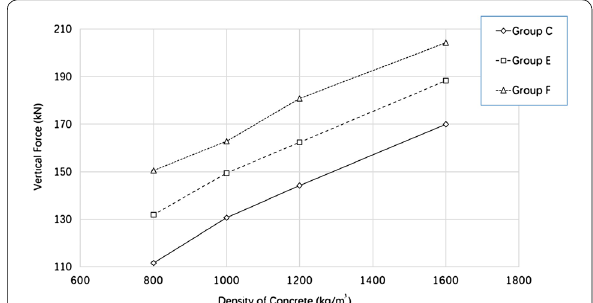
Fig. 5 Peak force for different groups of